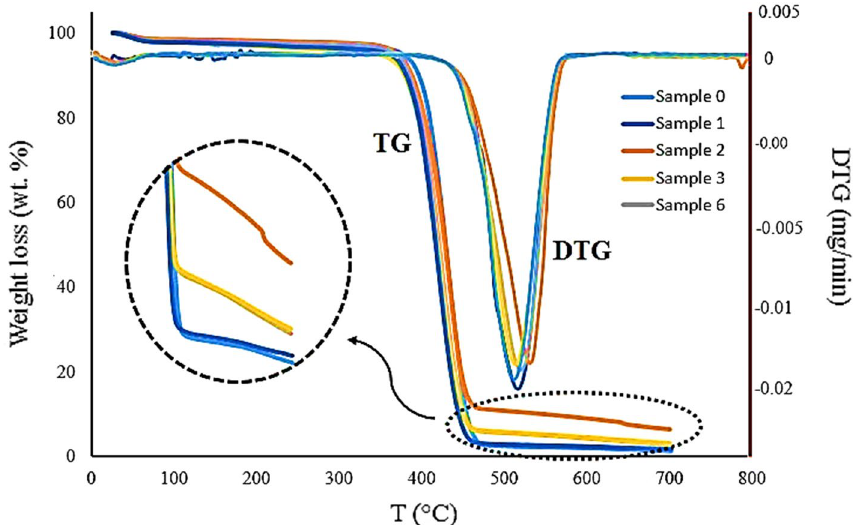
Figure 2. TGA curves of different coated Spunbond fabrics. Sample 0 (Uncoated fabric), Samples 1, 2, 3 (NS-coated fabrics at 2, 10, and 20 mM silver nitrate concentrations, and 25 min sonication time, respectively), Sample 6 (NS-coated fabrics at 10 mM silver nitrate concentration and 50 min sonication